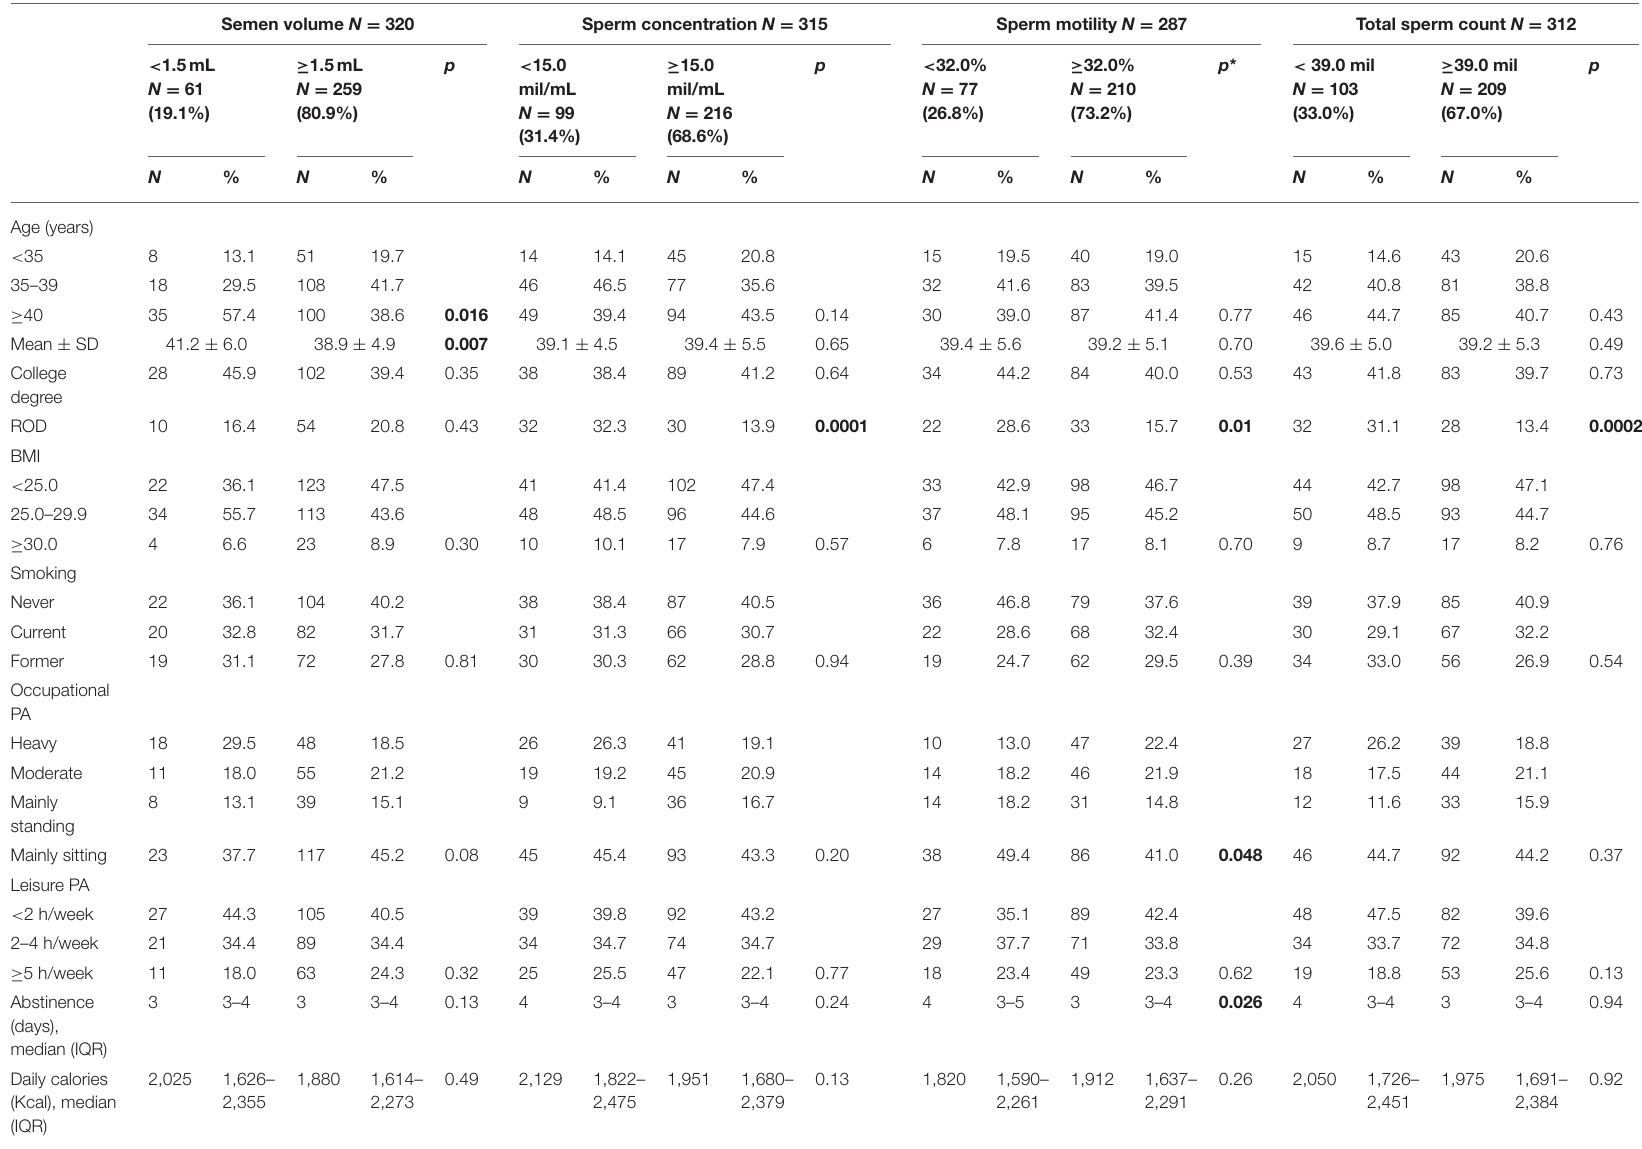
TABLE 2 | Demographic characteristics and lifestyle patterns of 323 men undergoing assisted reproduction technique, according to presence of sperm abnormalities. Semen volume N = 320 Sperm concentration N = 315 Sperm motility N = 287 Total sperm count N =